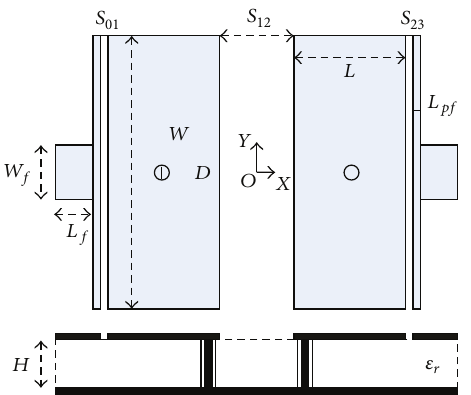
Figure 5: Geometry of the radiating filter. (Upper figure is the top view and lower one is side view.) 𝑊 𝑓 = 12 mm, 𝐿 𝑓 = 5 mm, 𝐿 𝑝𝑓 = 1mm, 𝑆 01 = 𝑆 23 = 2 mm, and 𝑆 12 = 2.9 mm. Dimension: 30mm × 26.3 mm × 3 mm ( 𝜆 0 /4 × 𝜆 0 /5 × 𝜆 0 /40 ). Figure 6: 𝑆 parameters of the proposed radiating filter. Bandwidth in HFSS simulation: [2.53 GHz, 2.70 GHz], 6.5%. Bandwidth in measurement (2.50 GHz, 2.72 GHz),